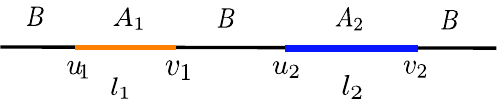
Fig. 1 Two disjoint intervals A 1 and A